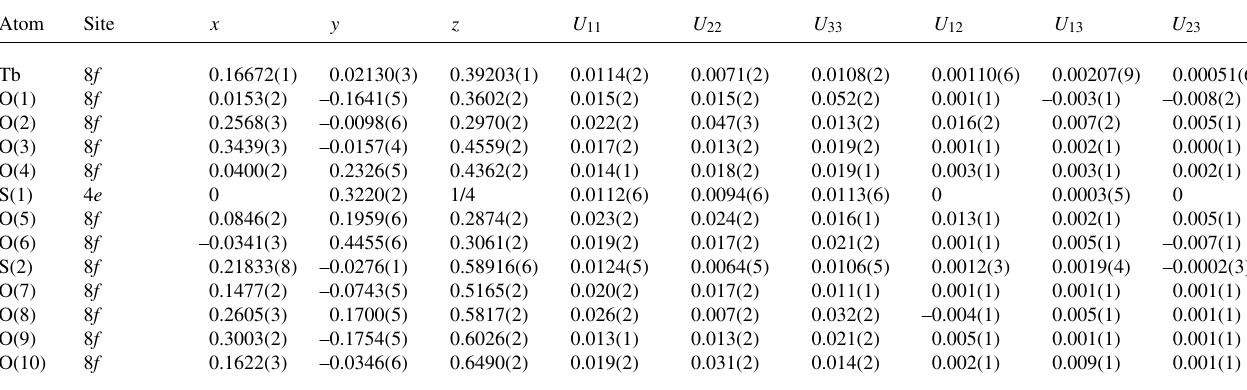
Table 3. Atomic coordinates and displacement parameters (in Å 2 )